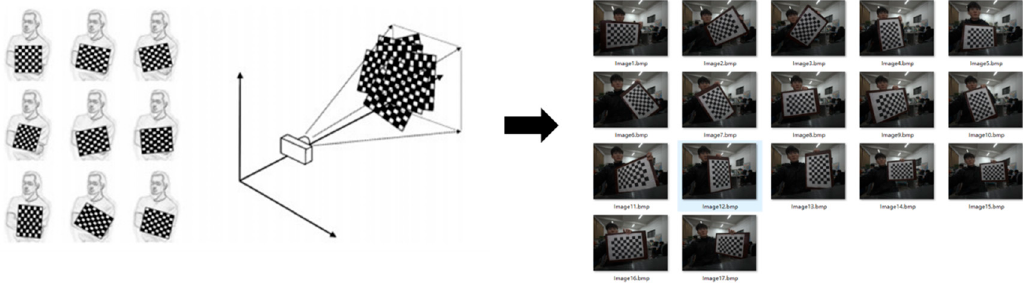
Figure 4. The 17 images were taken by changing the position and angle of the calibration plate.